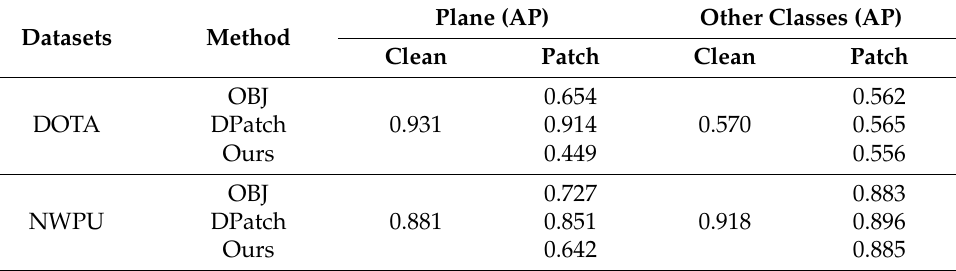
Table 2. Effect of the different attack methods on the detection results of other categories of